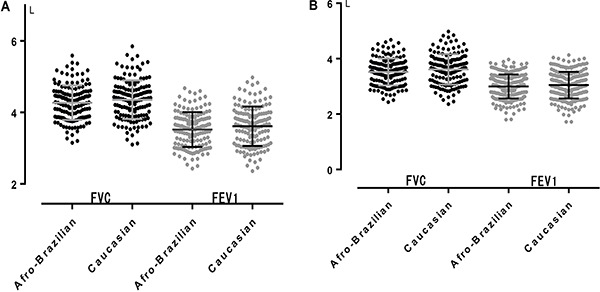
Forced vital capacity (FVC) and forced expiratory volume in 1 second (FEV1) in two Brazilian ethnicities. Horizontal lines indicate mean±SD.